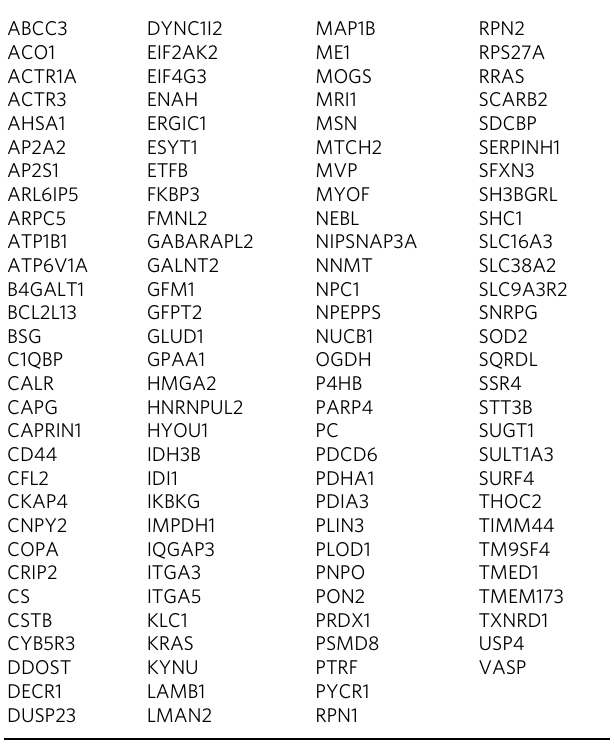
Table 1 BCL-X L -dependent RAS-induced proteins